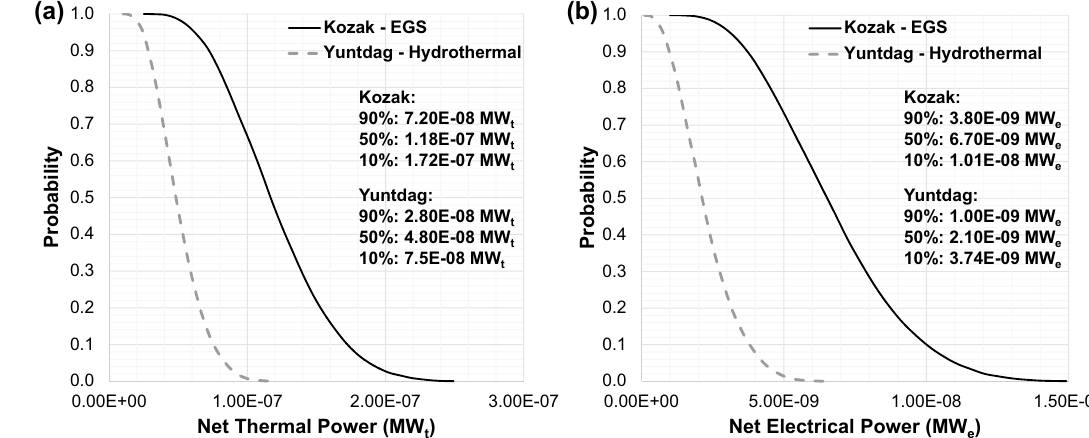
Fig. 9 Cumulative expectation curve for unit-volume case a direct utilization, b indirect